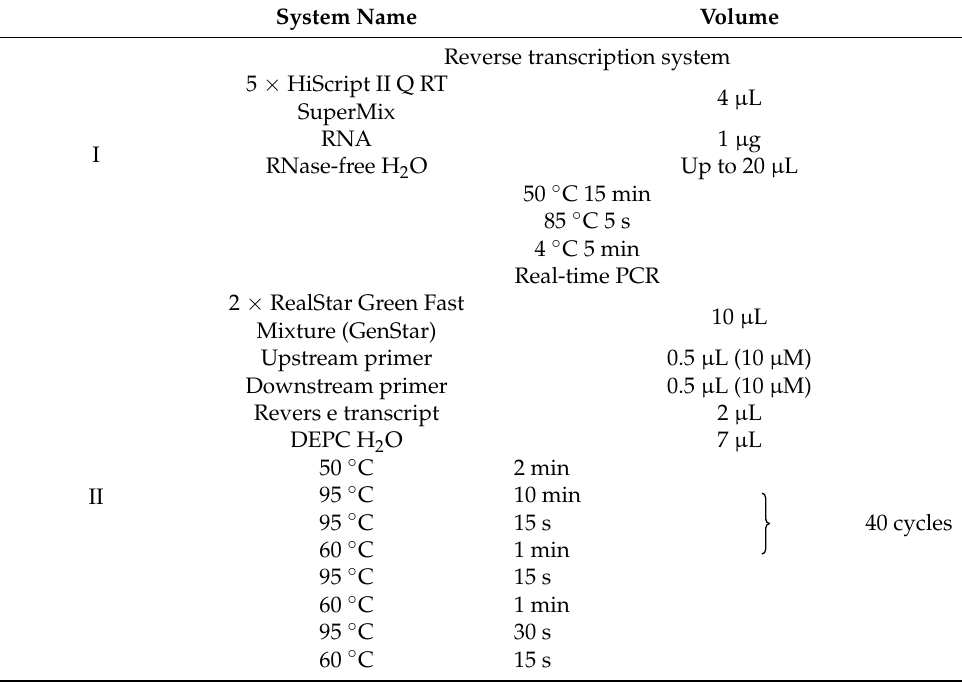
Table 1. Reaction system of quantitative real-time PCR.